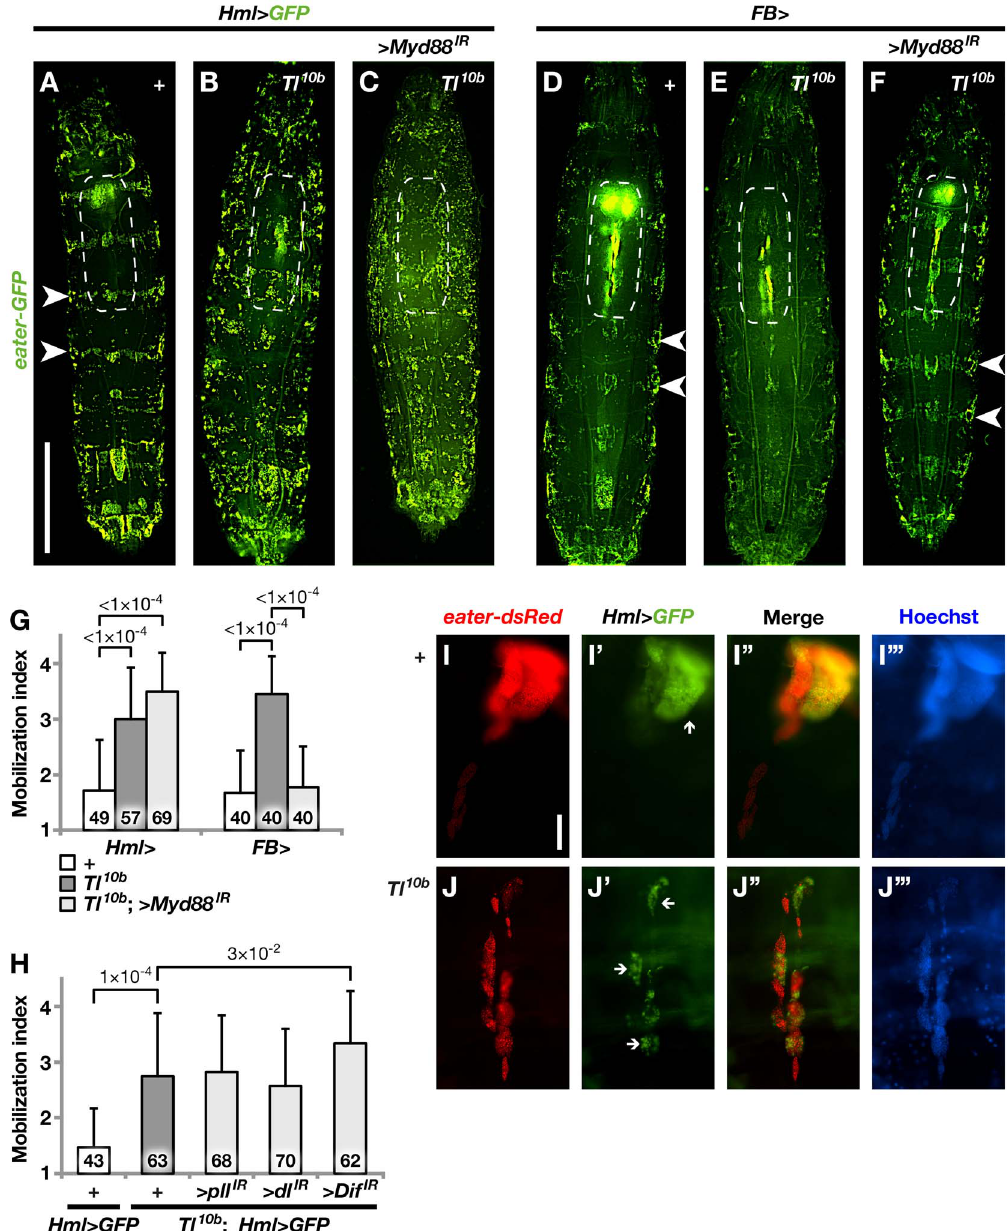
Figure 2. Mobilization of sessile hemocytes in the Toll 10b gain-of-function mutant is suppressed after blocking Toll signaling in the fat body but not in the hemocytes. A–F . Plasmatocyte distribution is shown in control ( + ) and Toll 10b gain-of-function mutant ( Tl 10b ) third instar larvae, with or without suppression of Toll signaling by the UAS-MyD88 GD25399 construct ( . MyD88 IR ), driven in hemocytes by Hml D -Gal4 ( Hml . ) or in fat body by FB-Gal4 ( FB . ). The plasmatocytes are visualized by Hml D -Gal4 -driven UAS-GFP and the eater-GFP reporter (in A–C), or by eater-GFP alone (in D–F). Segmental bands of sessile plasmatocytes (white arrowheads) indicate that the plasmatocytes are in a resting state. Dashed lines demarcate the region occupied by the lymph glands. G . Quantification of the mobilization of sessile plasmatocytes in larvae of the genotypes shown in panel A. Mobilization index=1 corresponds to a fully developed banding pattern and 4 indicates total loss of the sessile bands. The bars show the means + / 2 standard deviation, and sample sizes N are shown within the bars. H . Additional genotypes tested as in G. I , J . Morphology of dissected lymph glands from control (I–I 999 ) or Toll 10b mutant (J–J 999 ) third instar larvae. Two plasmatocyte reporters are used to visualize the cells, Hml D -Gal4 -driven UAS-GFP , which stains differentiated plasmatocytes in the lymph gland cortex, and eater-DsRed , which is also seen in the undifferentiated medullary cells. The larvae and lymph glands are oriented with the anterior end up. Size bar in A–F corresponds to 1 mm and in I–J to 0.1 mm. doi:10.1371/journal.pone.0102568.g002 These melanotic nodules became less frequent when we blocked nodules increased when we blocked Toll signaling in the hemocytes (Fig. 3C and K). Expressing RNAi constructs that construct (Fig. 3E and K). Furthermore the remaining nodules target other known Toll signaling components in hemocytes had a were smaller (Fig. 3E). In contrast, the size of and frequency of similar effect (Fig. 3L). MyD88 knock-down in both fat body and